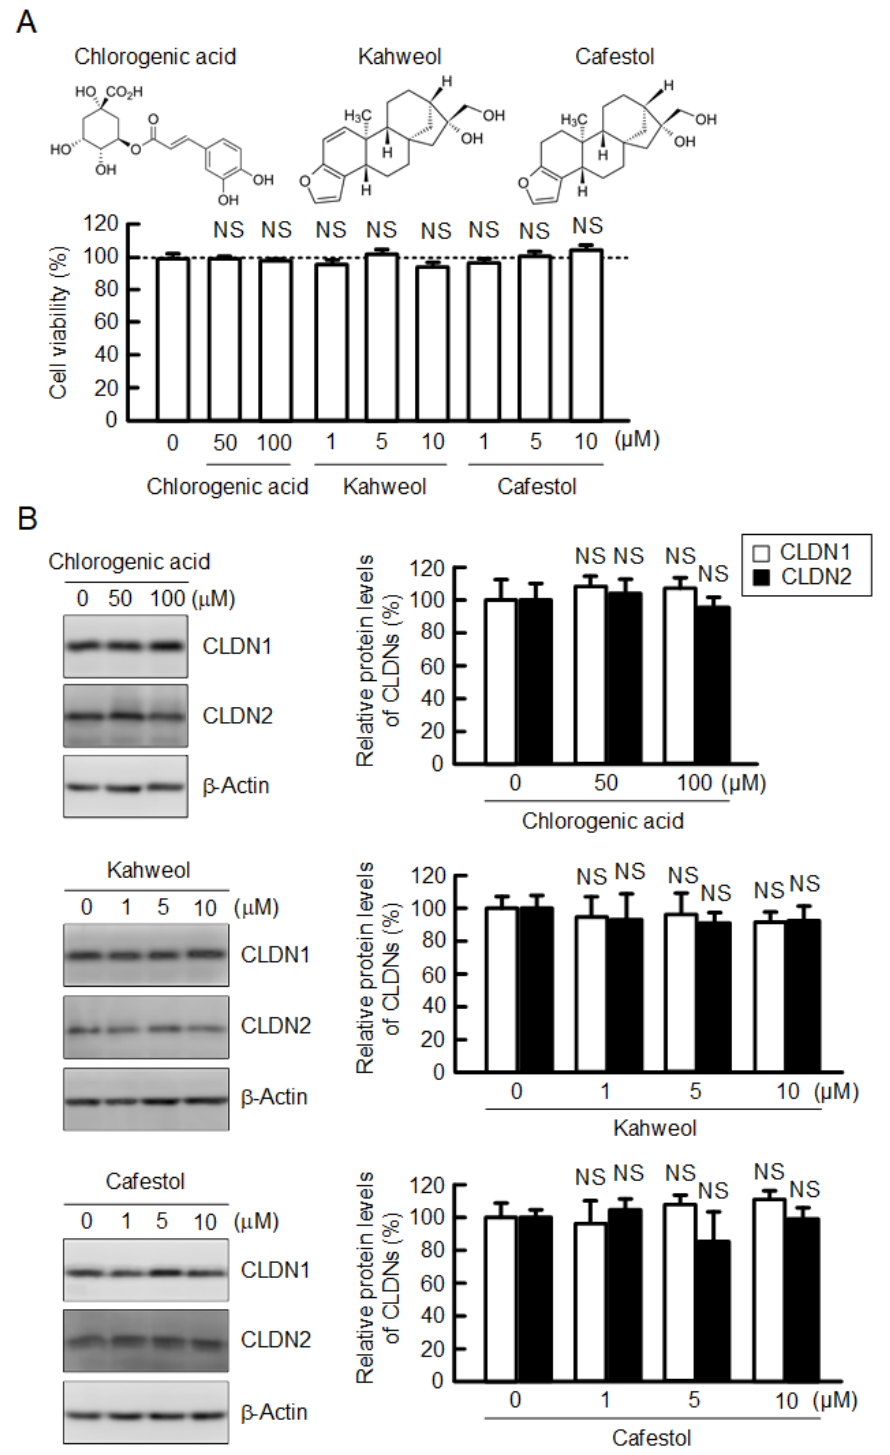
Figure 2. Effects of chlorogenic acid, kahweol, and cafestol on cell viability and CLDN expression. ( A ) The structures of chlorogenic acid, kahweol, and cafestol are shown in the upper panel. Cells were incubated with chlorogenic acid, kahweol, and cafestol at the indicated concentrations for 24 h, followed by incubation with CCK-8 reagent. Cell viability is represented as a percentage relative to 0 µ M. ( B ) The expression levels of CLDN1, CLDN2, and β -actin were examined by Western blotting. The protein levels of CLDN1 and CLDN2 are represented as a percentage relative to 0 µ M. n = 3–5. NS p > 0.05 compared with 0 µ